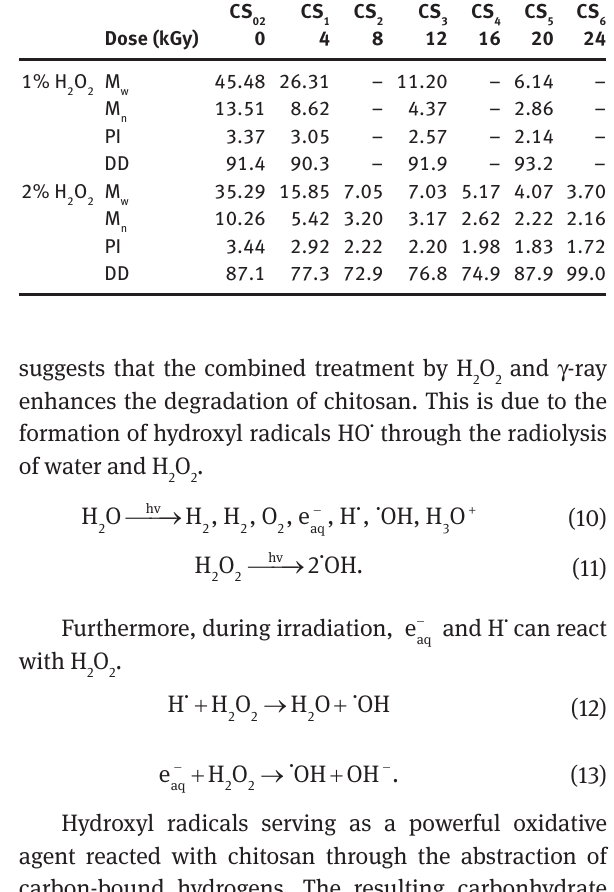
Table 2: M treated with H